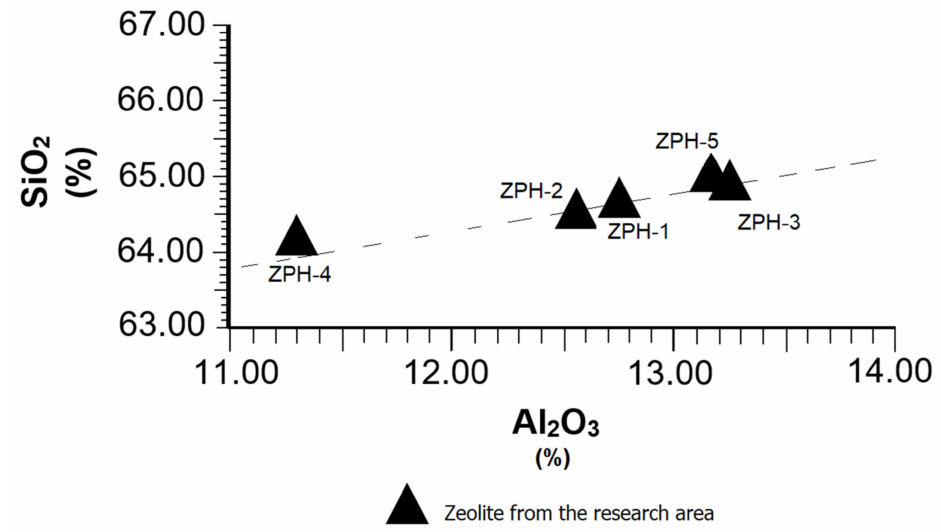
Figure 4. Behaviour of the SiO 2 vs. Al 2 O 3 in the